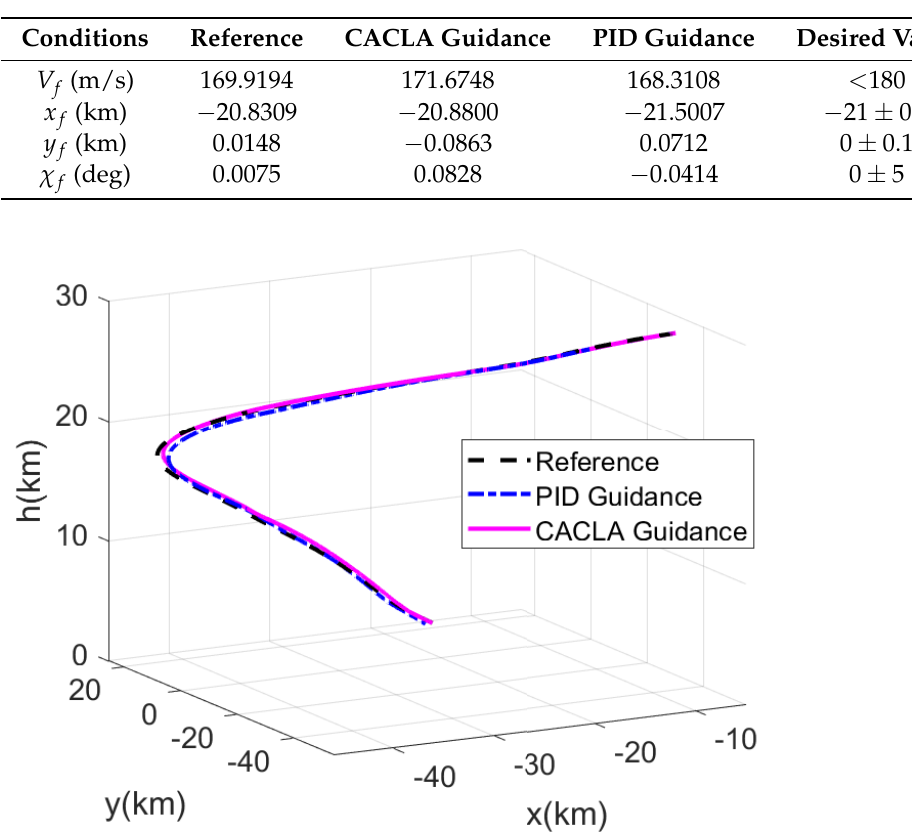
Figure 7. Three-dimensional TAEM trajectories of RLV in comparison